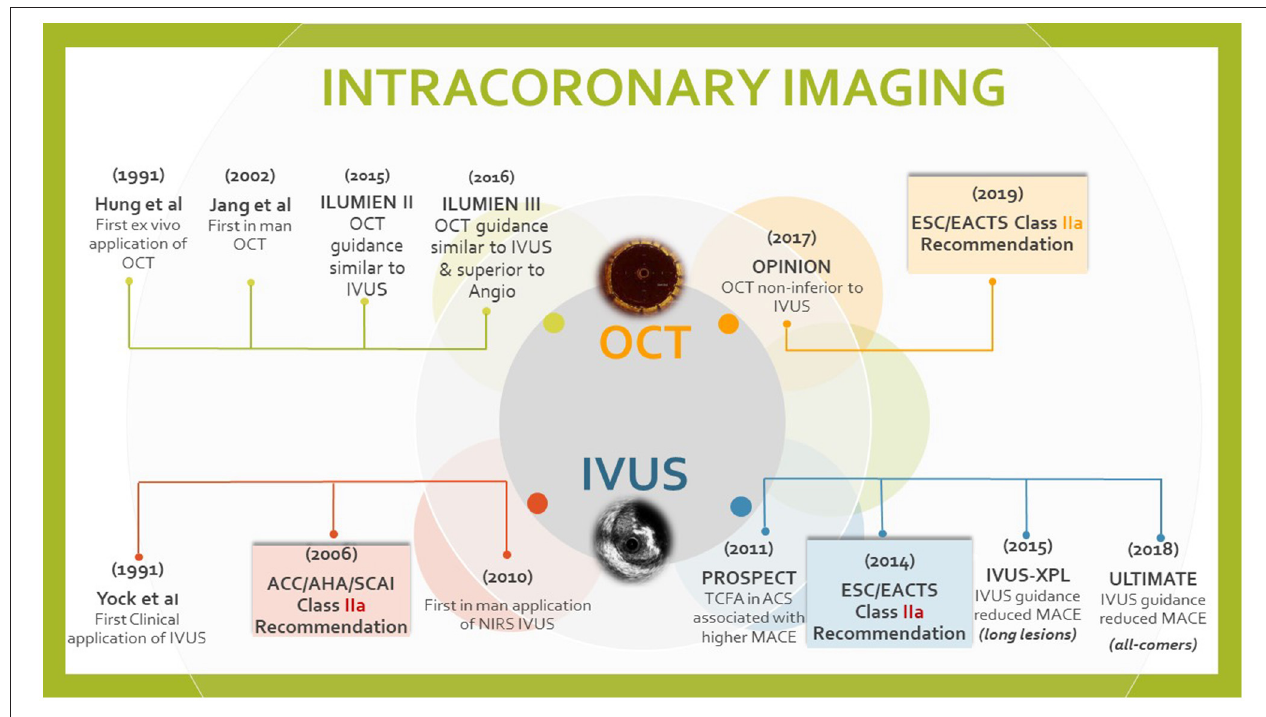
FIGURE 5 | Illustration summarizing the most relevant trials addressing both modalities and the latest guidelines.